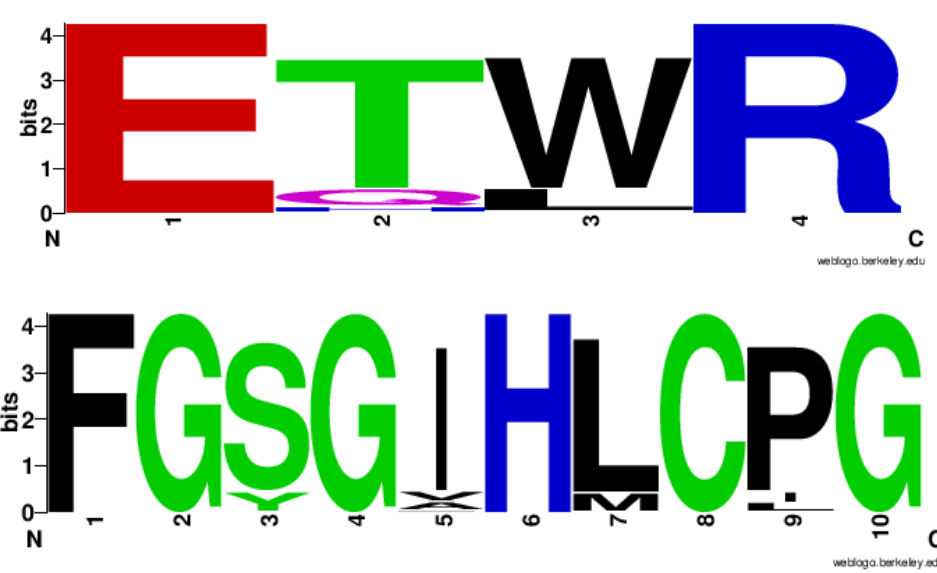
Figure 4. Analysis of amino acid patterns at the EXXR and CXG motif in the CYP128 P450 family. All CYP128 P450 sequences (total of 2674 sequences) were analyzed for the EXXR and CXG signature motifs.